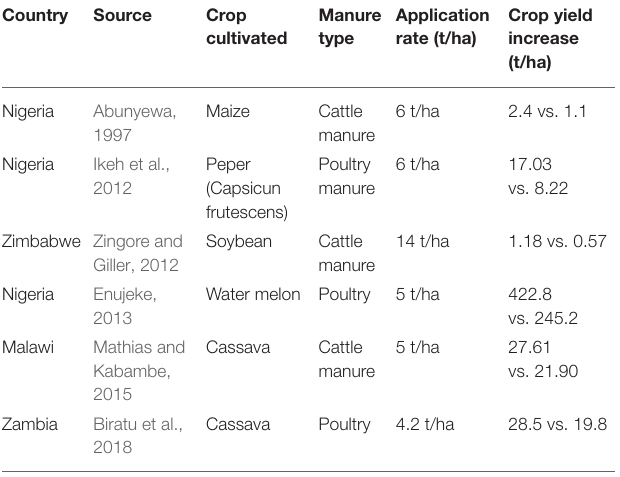
FIGURE 1 | Nutrient cycle in crop-livestock